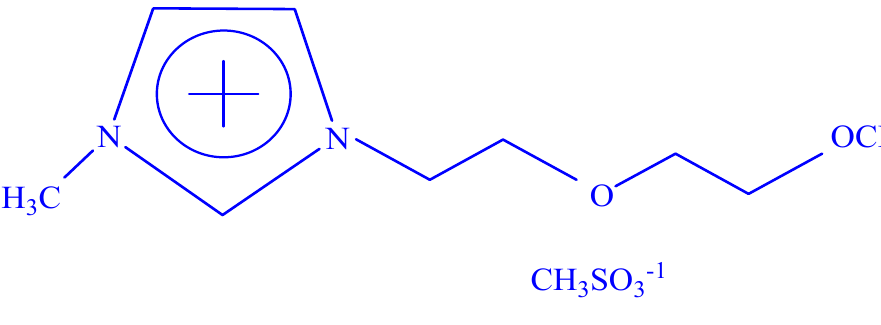
Figure 1. Structure of DOMIMS.